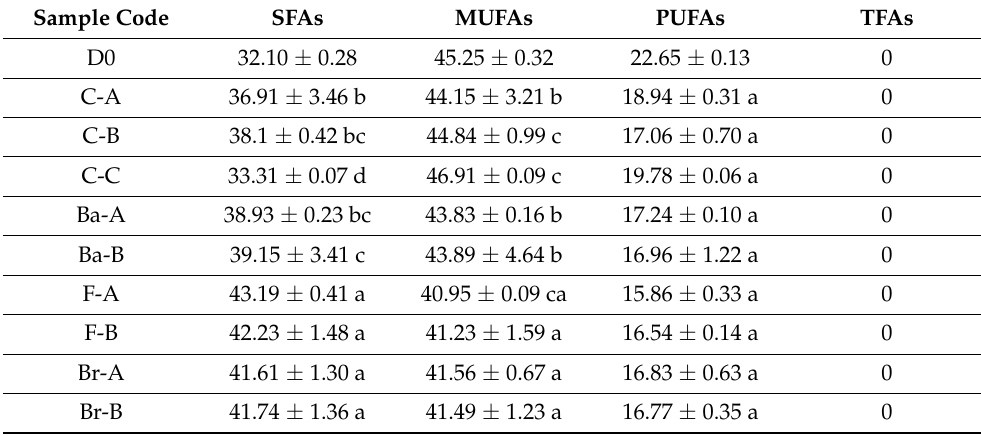
Table 9. Content of SFAs, MUFAs, PUFAs, and TFAs in chicken breast culinary samples. Sample